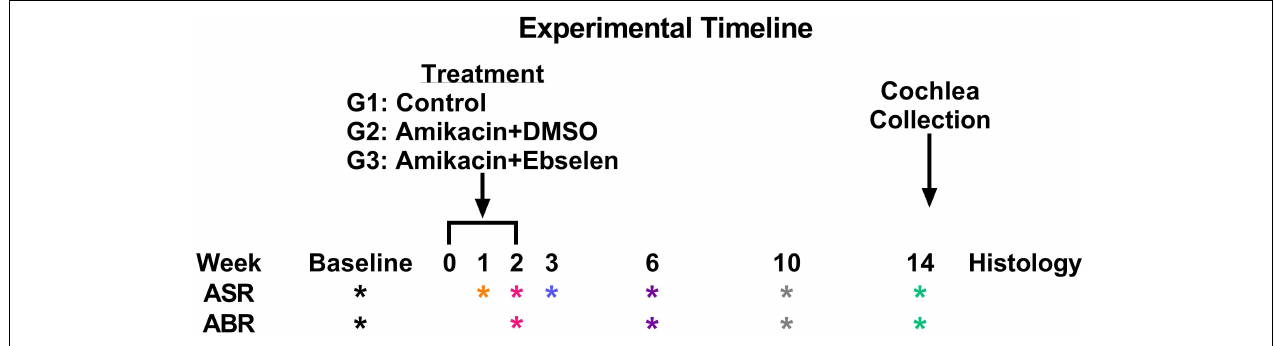
FIGURE 1 | Experimental timeline. ASR and ABR tests ( ∗ symbol) are color coded to specific weeks the tests occurred after the start of treatment. This color code is maintained throughout the manuscript. Treatment regimens were carried out from week 0 to 2 for groups (G) 2 and 3, while group 1 did not receive any treatment. Animals were sacrificed after week 14 tests for cochlear